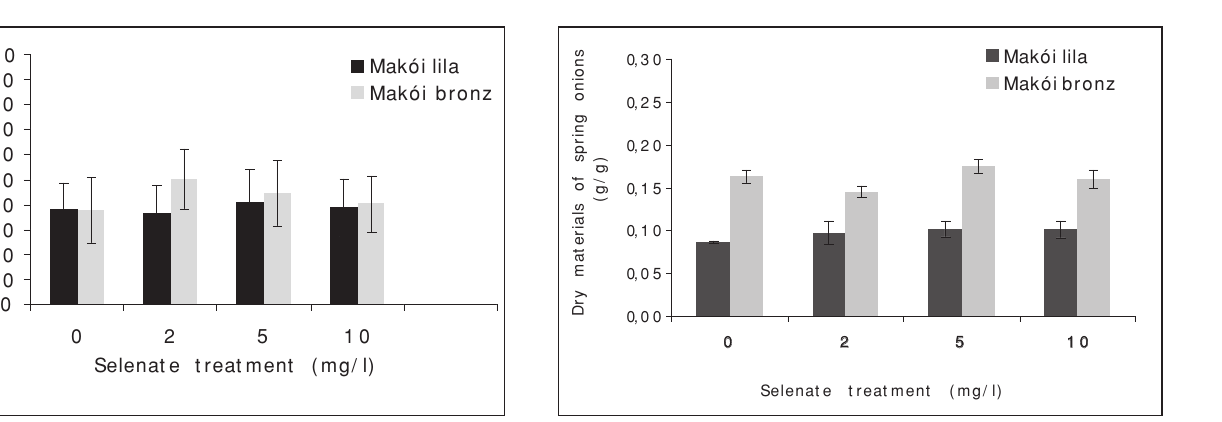
Fig. 3: Dry matter content of Makói bronz and Makói lila spring onions depending on selenate treatments (p<0,05) (+/-SE)